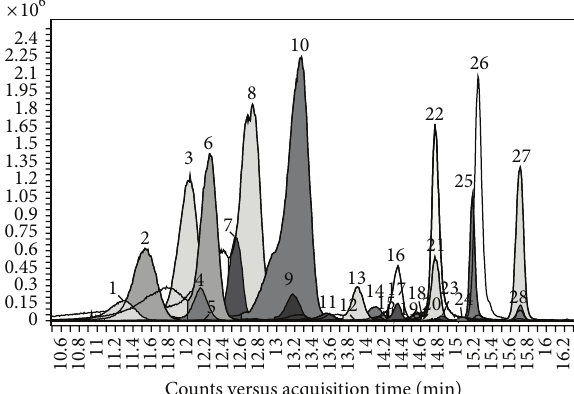
Figure 4: Extracted ion chromatograms of M +∙ ion signals of anthocyanins identified in the UHPLC/QTOF analysis of Clinton grape